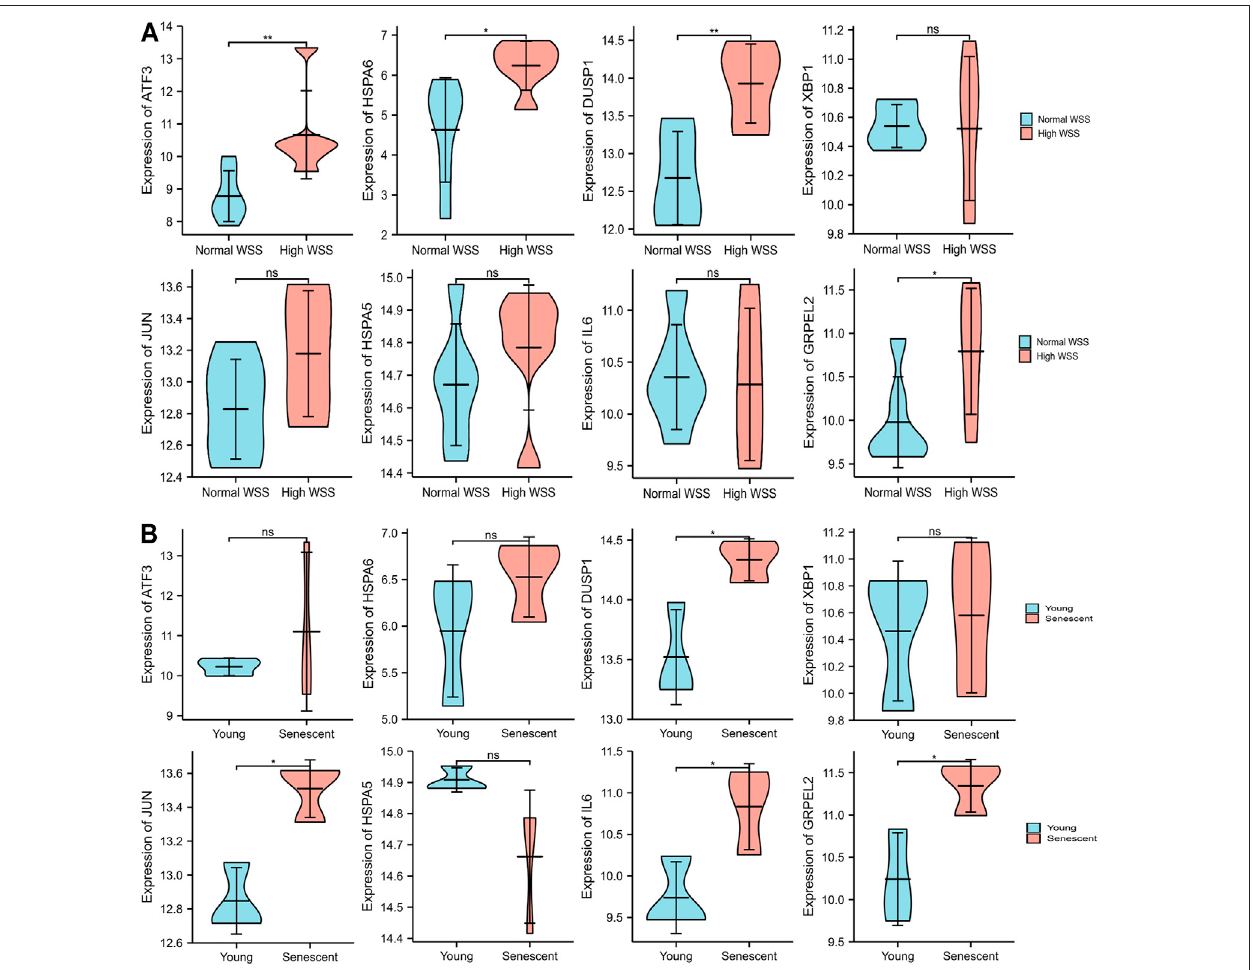
FIGURE 8 | The expression level validation of hub genes. (A) A comparison of the expressed level of the hub genes between normal and high WSS groups in the GSE13712 data set. Compared with the normal group, hub genes(ATF3, DUSP1, HSPA6, and GRPLE2) are highly expressed in the high WSS group with signi fi cance. (B) Thecomparison of theexpressed levels of thehub genes between theyoungand senescent HUVEC groups under high WSS in the GSE13712 data set.Compared with the young HUVECs group, DUSP1, GRPEL2, and JUN were highly expressed in the senescent HUVECs group, while others have no signi fi cance. * p < 0.05, ** p < 0.01, ns: p > 0.05, no signi fi